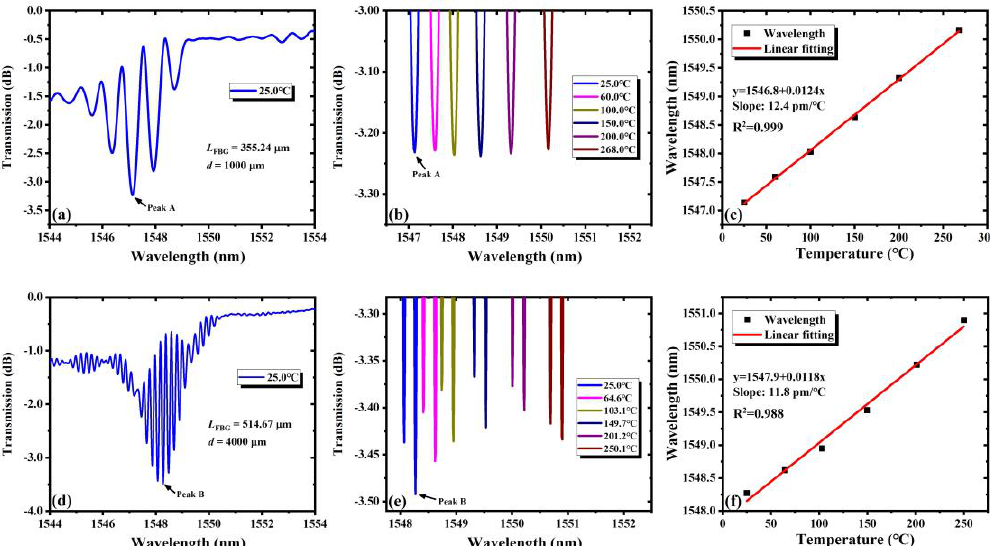
Figure 8. Results of the measured temperature response characteristics: ( a – c ) FPC-I; ( d – f ) FPC-IV. ( a , d ) The transmission spectra; ( b , e ) the resonance peaks shift with temperature; ( c , f ) the linear fitting of the peak wavelength shift.